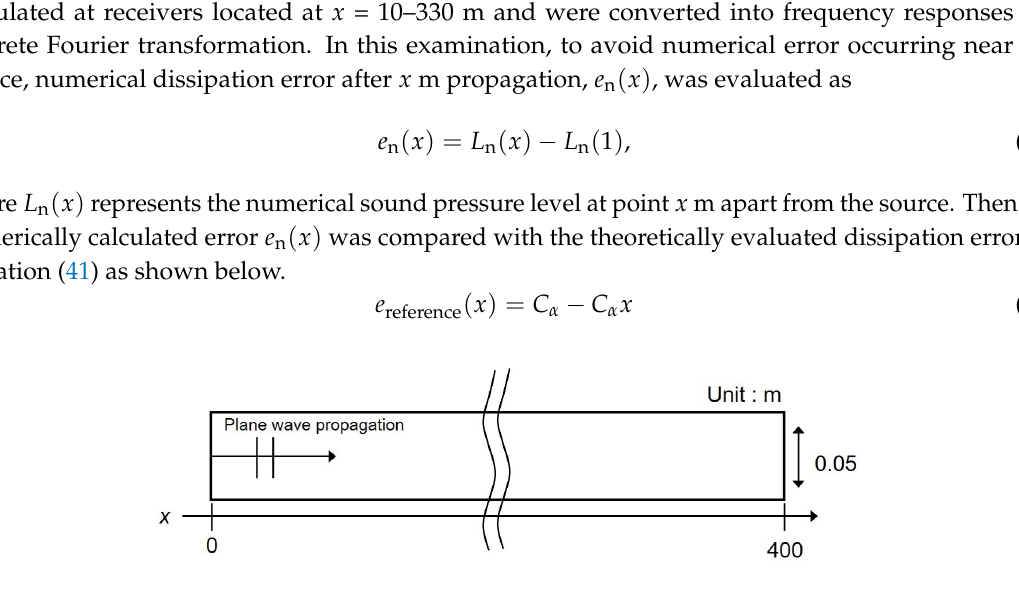
Figure 6. Long numerical duct model with 400 m